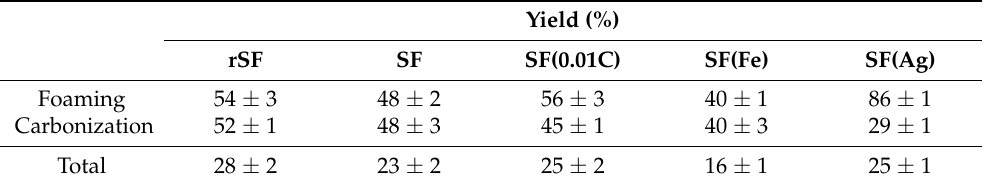
Table 2. Yields obtained for different carbon foams prepared from